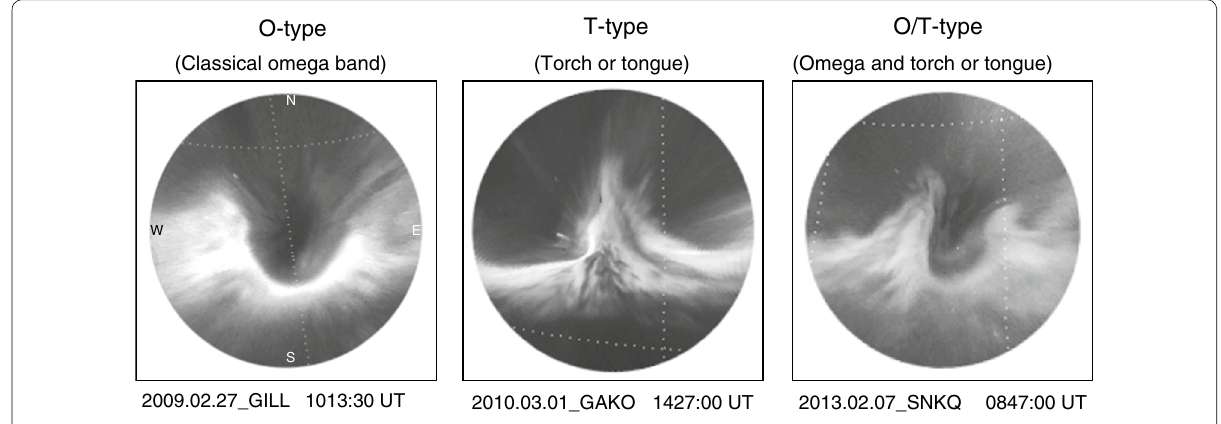
Fig. 1 Examples of ( left ) O-type, ( middle ) T-type, and ( right ) O/T-type omega bands